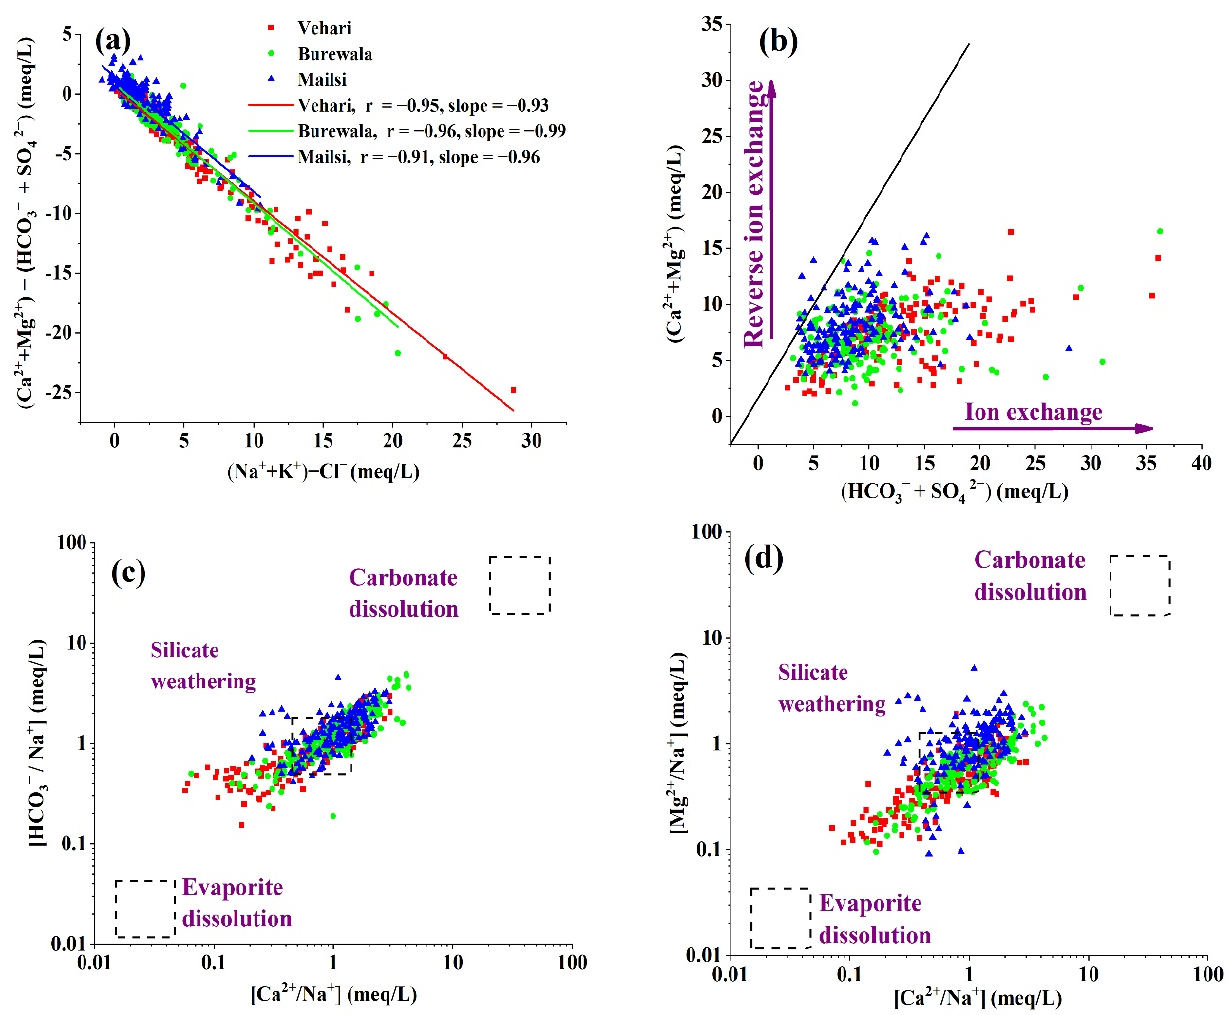
Figure 3. Scattered ionic plots. ( a ) [(Ca 2+ + Mg 2+ ) − (HCO 3 − + SO 42 − )] vs. [(Na + + K) − Cl − ]. ( b ) [(Ca 2+ + Mg 2+ vs. HCO 3 − + SO 42 − )]. ( c ) [(HCO 3 − /Na + ) vs. (Ca 2+ /Na + )]. ( d ) [(Mg 2+ /Na + ) vs. (Ca 2+ /Na + )].